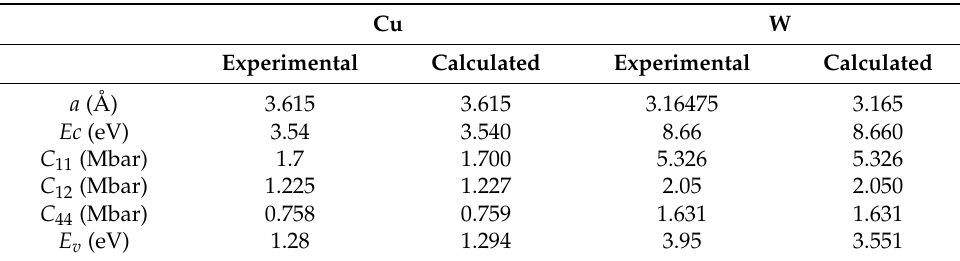
Table 2. Comparison between the bulk and physical properties of pure Cu and W calculated using the present potentials and their reference experimental values.